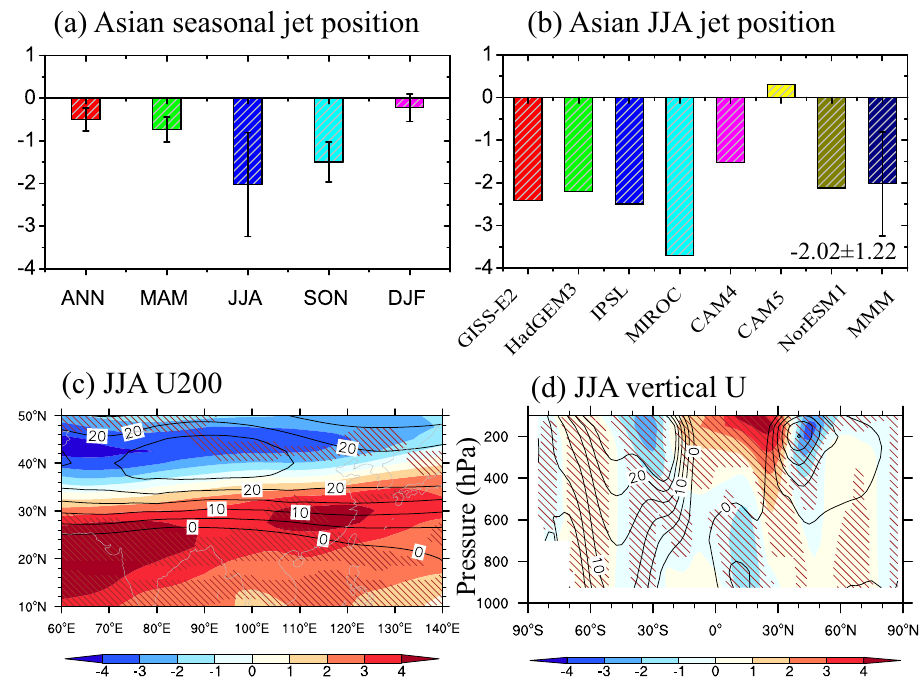
Fig. 3 Asian sulfate-induced changes in Asian westerlies and westerly jet stream position. a Changes induced by increasing Asian sulfate (SULx10Asia) in seasonal westerly jet position (degree latitude) for the multi-model mean (MMM). b Changes in JJA westerly jet position for individual PDRMIP models and MMM. c Spatial pattern of changes in JJA westerlies at 200 hPa (U200, m s − 1 ) for MMM and ( d ) in zonal mean JJA westerlies (U, m s − 1 ). Thin black contour lines in ( c , d ) show the climatological westerlies. Error bars of MMM in ( a , b ) represent the standard deviation among the PDRMIP models and slanted lines in ( c , d ) represent where MMM is more than 1 standard deviation away from 0.